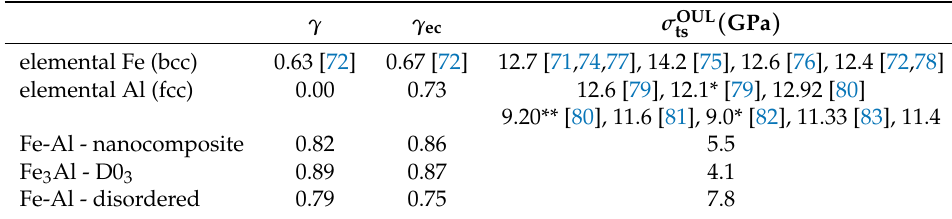
Table 2. The coefficients γ and γ ec from Equation (3) that were determined directly from the stress-strain dependence and via Equation (4), respectively. The Table also contains the tensile strengths σ OUL for elemental Fe (bcc) [71,72,74–78], Al (fcc) (present calculations and Refs. [79–83]) and Fe-Al-based systems. Most values of strength given in the Table correspond to the maximum of stress at the stress-strain curve. All values without a reference come from the present work. The γ ec for Al was computed from Equation (4) and the elastic constants were taken from Ref. [84] ( C 11 = 123 GPa, C 12 = 70.8 GPa and C 44 = 30.9 GPa). The values of γ ec for Fe-Al systems were obtained from the elastic constants calculated here (see Table